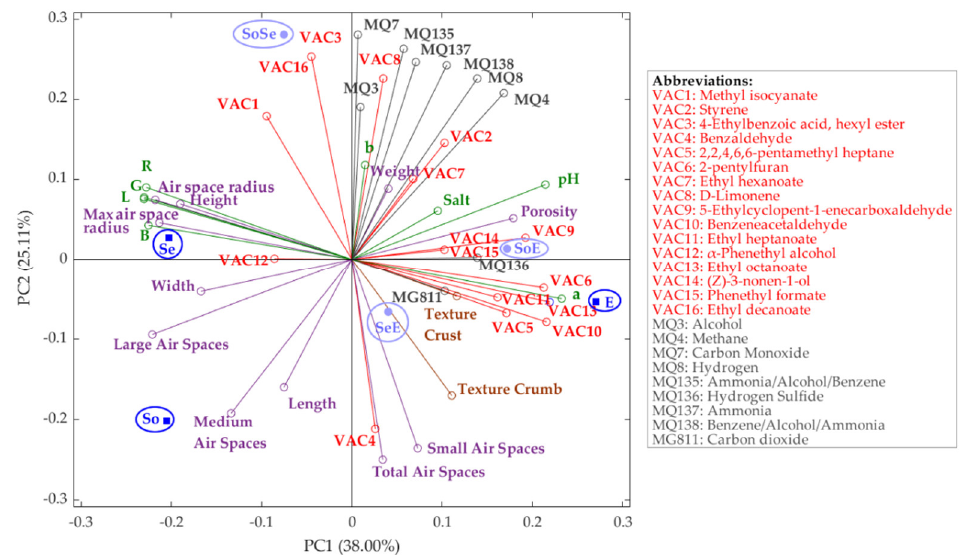
Figure 7. Principal components analysis (PCA) showing all variables from volatile aromatic com- pounds (VAC; red), volatile compounds assessed using the electronic nose (gray), color (green), chemical (blue), texture (brown), and physical (purple) measurements. Abbreviations: PC1 and PC2: principal components one and two; Max: maximum; So: soft wheat; Se: semola; E: Emmer wheat; SoSe: soft wheat and semola; SoE: soft and Emmer wheat; SeE: semola and Emmer wheat.